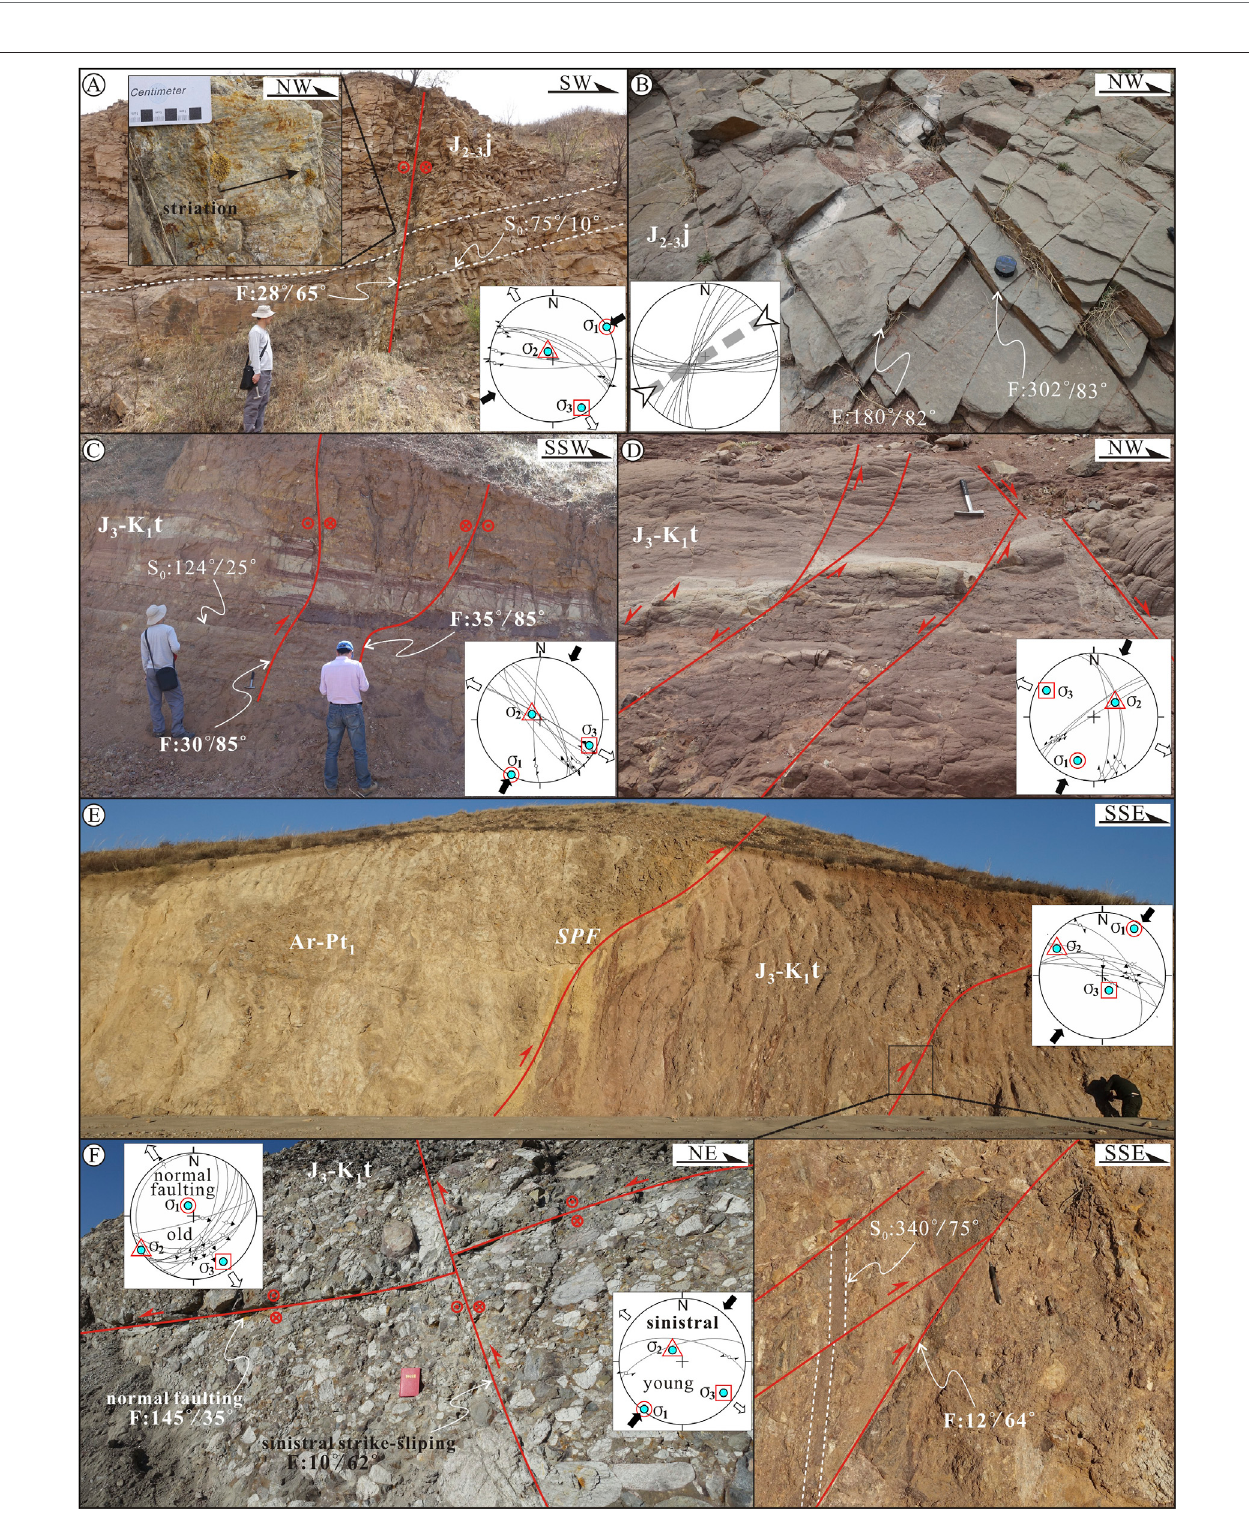
FIGURE 9 | Representative outcrop photographs related to regional NE-SW compression. (A) Outcrop-scale WNW-striking strike-slip fault crop out in the pebbly sandstonesoftheJiulongshanFormation,andaNE-SWcompressivestressobtainedbyinversionoffault-slipvectors. (B) TheX-typeconjugateshearfractureswithNE-directed acute-angledbisectoraredevelopedintheJiulongshanFormationsandstones. (C , D) Conjugatestrike-slipfaultsassociatedwithNE-SWcompressionaldeformationaremarked intheTuchengziFormation. (E) NearthewestofDaxigou,evidenceoffaultingrelatedtoNE-SWcompressionisdiscoveredintheTuchengziFormationsandyconglomerates fromthefootwalloftheSPF. (F) Two-phasefaultsareexposedintheTuchengziFormationconglomeratesatthenorthofTumulu,andtheSE-dippingnormalfaultsarecutbyNNE- dipping transpressional faults, corresponding to NW-SE extension and NE-SW compression, respectively. Lower hemisphere, equal-area projections.